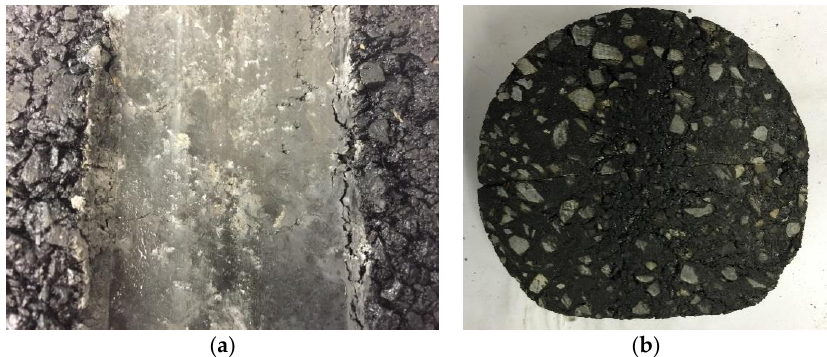
Figure 8. Specimen #3 (1.5 inch thickness, 10 days aging, with a notch) with SIRC, ( a ) specimen top and ( b ) specimen bottom.